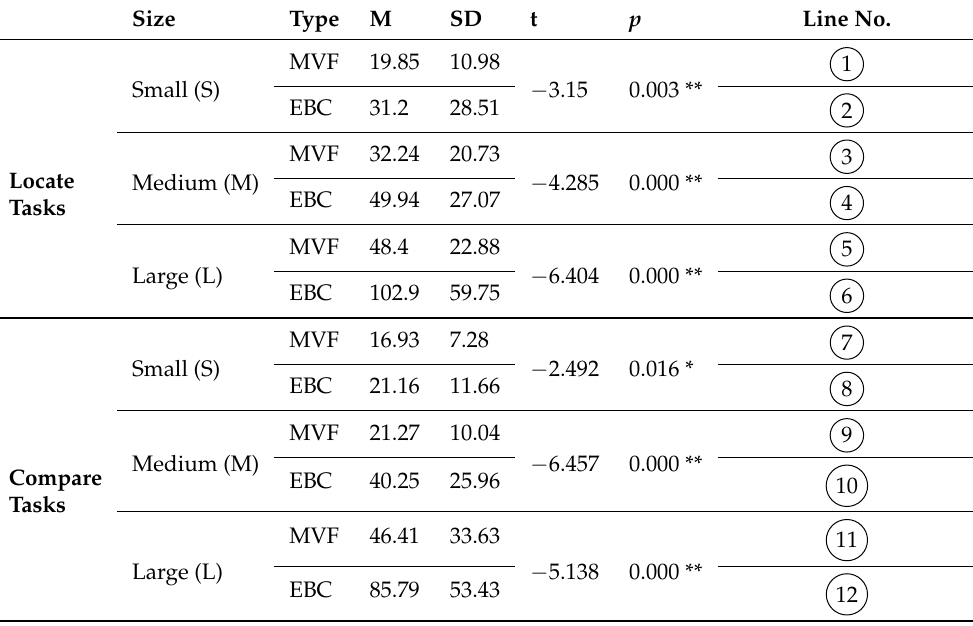
Table 2. Means of completion time, with the standard deviation of the measured mean in seconds. Differences in accuracy are indicated by *. Significant differences in accuracy are indicated by